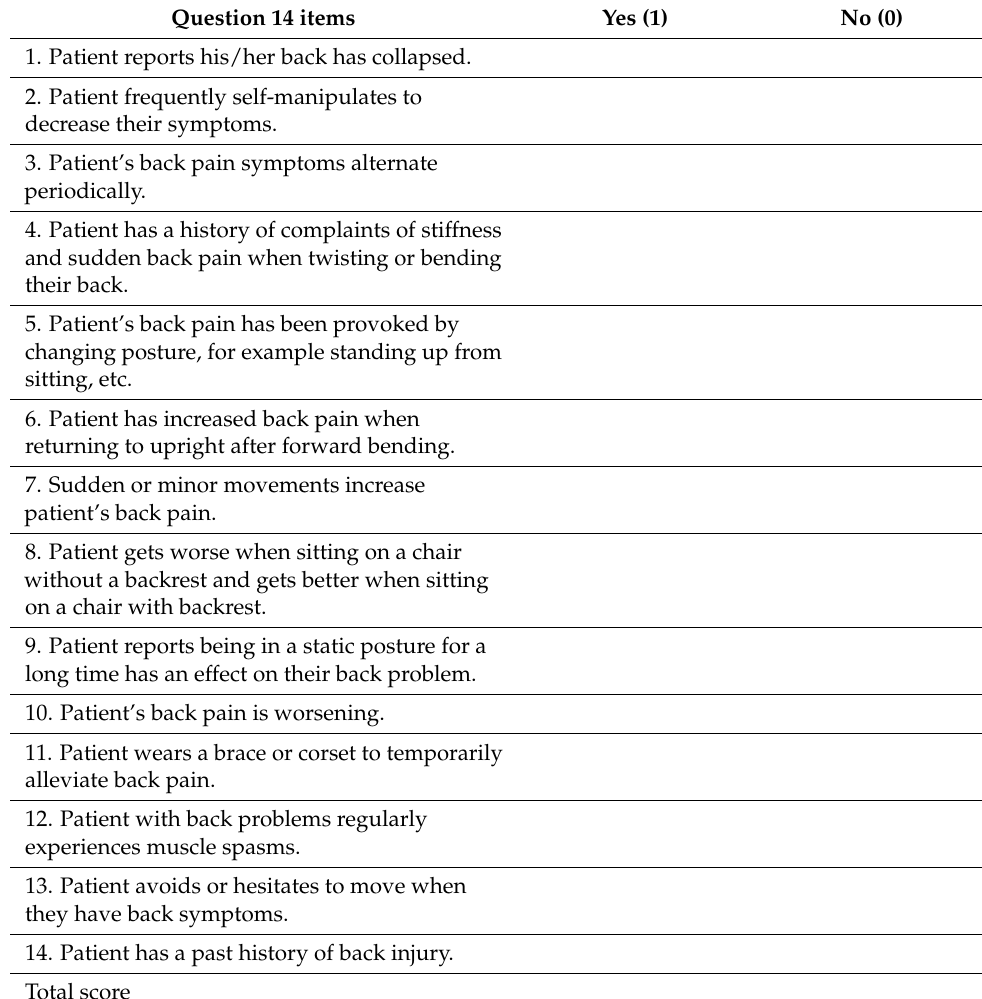
Table 1. Lumbar instability screening